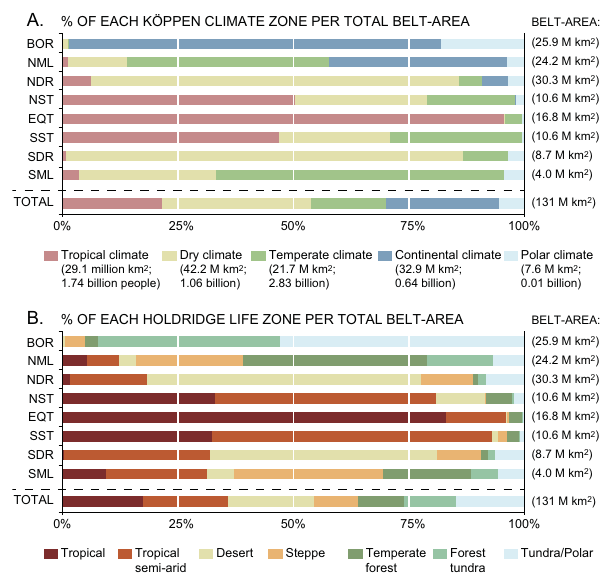
Fig. 5. Distribution of the proportions of K¨oppen climate zones (a) and of Holdridge life zones (b) in hydrobelts, in % of total for a given